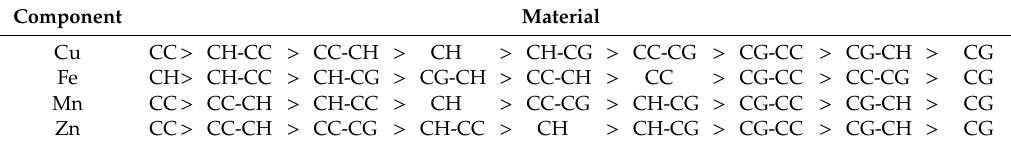
Table 4. Series of materials according to decreasing concentration of individual microelements in